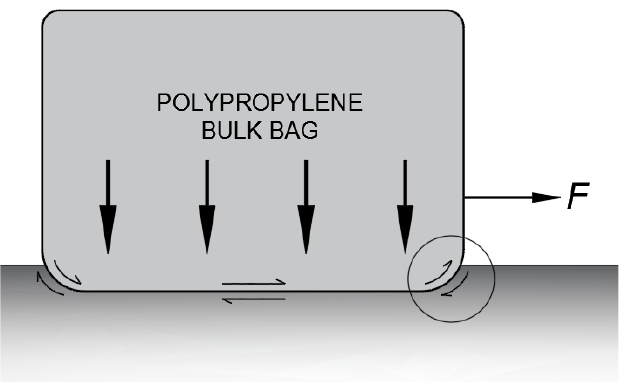
Figure 8. Exaggeration of proposed ‘dish effect’ encountered during testing of surface E. Therefore, a greater tensile force was required to initiate the displacement of the bag. The highest static frictional coefficient was measured on the unmade gravel road (ref F). The small friction coefficient measured from testing the polypropylene plastic sur- face (ref G) demonstrates that overlaying the natural bedding surface onsite during an emergency flooding scenario with a polypropylene DPM, as illustrated by Figure 9, is likely to reduce the frictional resistance generated along with the system–surface inter- face. Therefore, greater frictional resistance is likely to be achieved when the bulk bag directly interfaces with the site’s natural bedding surface [24]. Surfaces B–F are common bedding surfaces found within society; each provided a greater sliding resistance than when the DPM was placed beneath the bag(s).